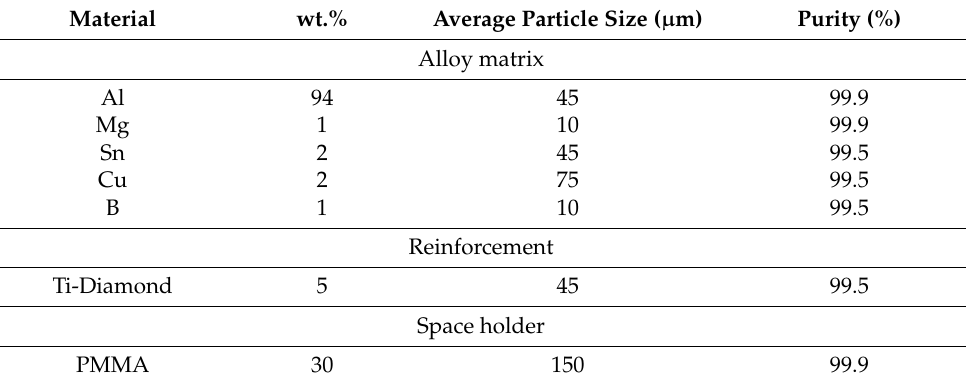
Table 1. Particle content, average particle size, and purity of powders for sample preparation. Material